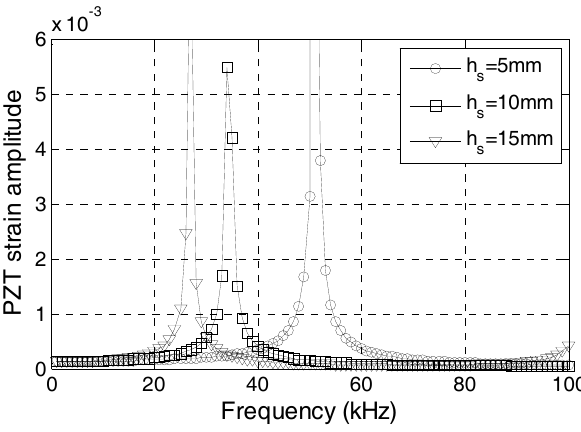
Figure 9. Frequency-strain curve with different protecting layer materials.